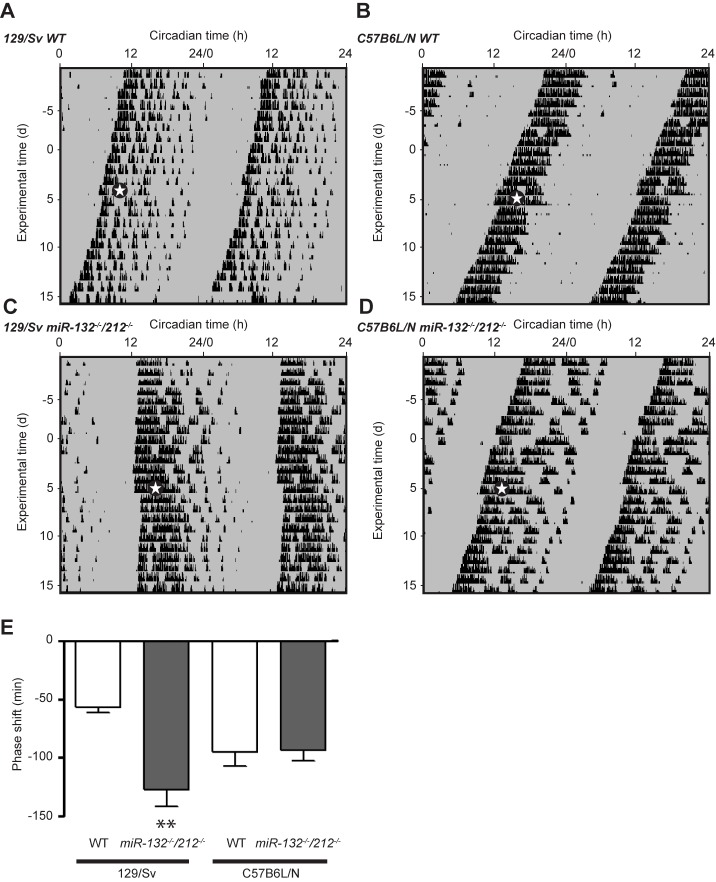
Influence of miR-132/212 deletion on behavioral phase shifts after single light pulses.(A-D) Representative actograms of WT (A, B) and KO (C, D) mice in constant darkness showing a brief (15-min) light pulse at CT15 of 20 lx which is marked by white stars and separates the free-running phase in two darkness periods (pre and post shift). (E) Magnitudes of phase shifts. 129/Sv: WT: -57.14 ± 4.5 min, n = 8; KO: -114 ± 15.4 min, n = 9; C57BL/6N: WT: -95 ± 12.1 min counts, n = 11; KO: -93.8 ± 8.4 min, n = 10,; two-way ANOVA for interaction F(1, 34) = 6.530, p = 0.0152, Sidak’s post-hoc test for genotype 129/Sv: p < 0.01, C57BL/6N: p > 0.05. Data are represented as mean ± SEM., ** p < 0.01.